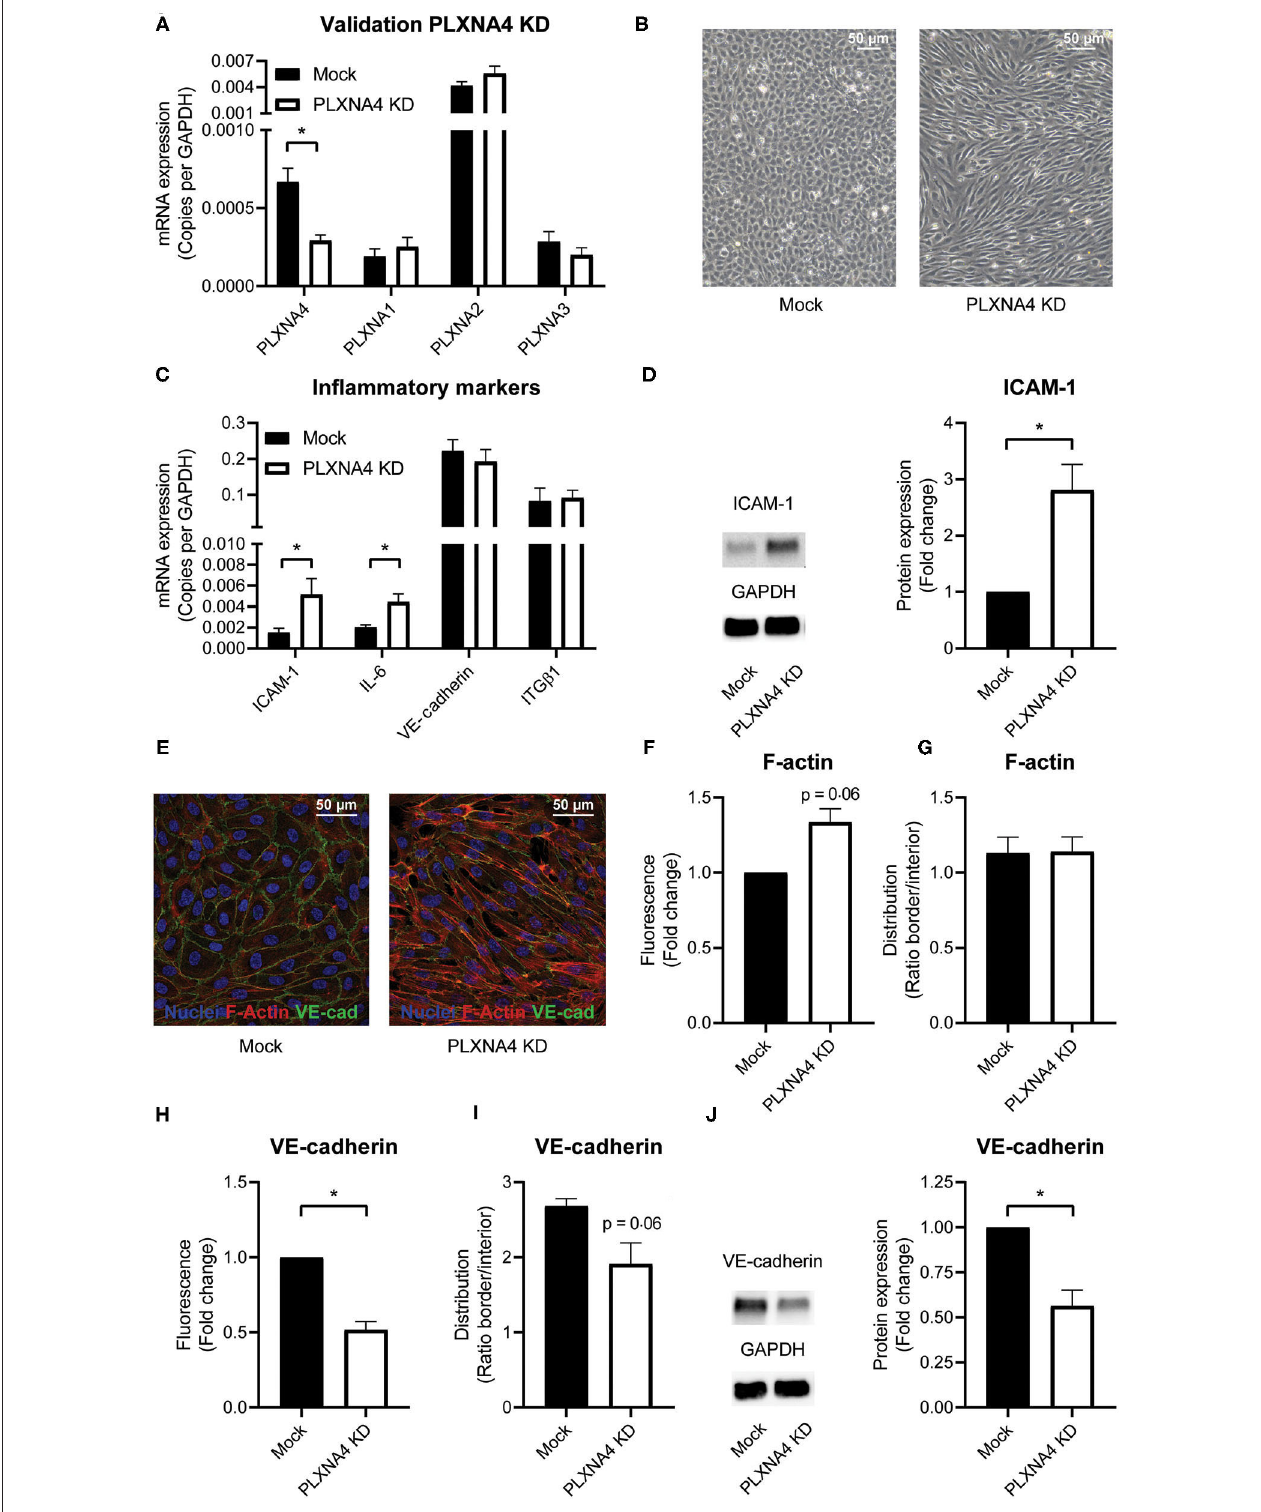
FIGURE 2 | PLXNA4 downregulation alters endothelial cellular phenotype. (A) mRNA expression of PLXNA4, PLXNA1, PLXNA2, and PLXNA3 in endothelial cells treated with a lentiviral non-targeting shRNA (mock) or a shRNA against PLXNA4 (PLXNA4 KD). Results are expressed as copies corrected for GAPDH. Mean ± S.E.M. of N = 27, * P < 0.05. (B) Representative overview pictures of mock-treated and PLXNA4 KD endothelial cells. (C) mRNA expression of ICAM-1, IL-6,